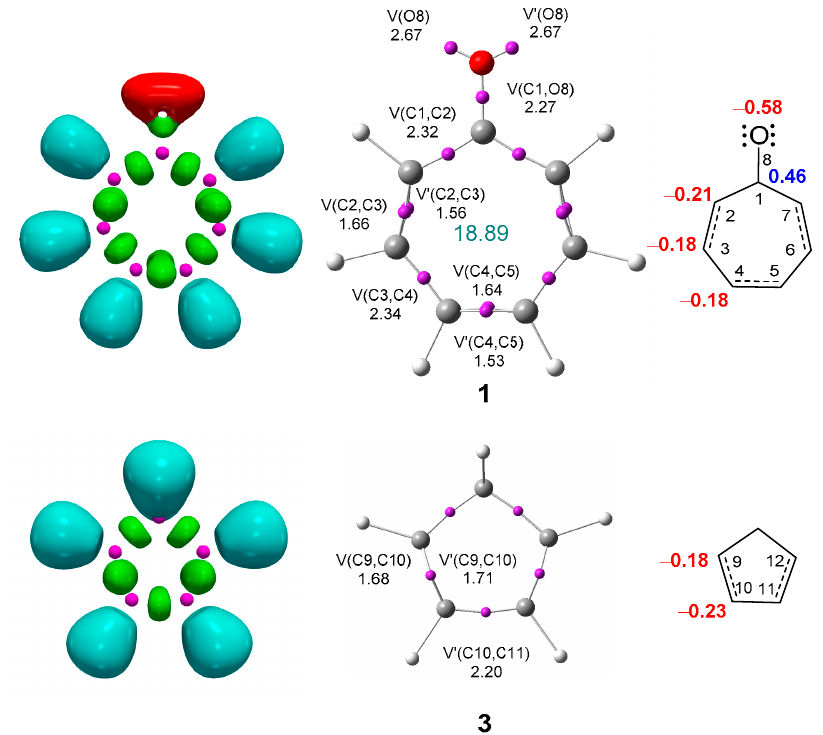
Figure 1. ELF localization domains represented at an isosurface value of ELF = 0.75, ELF basin attractor positions together with the most relevant valence basin populations, and ELF-based Lewis- like structures together with natural atomic charges of tropone 1 , and Cp 3 . The RED, in green, and the valence basin populations and natural atomic charges are provided in an average number of electrons, e. Negative charges are colored in red and positive charges in blue.